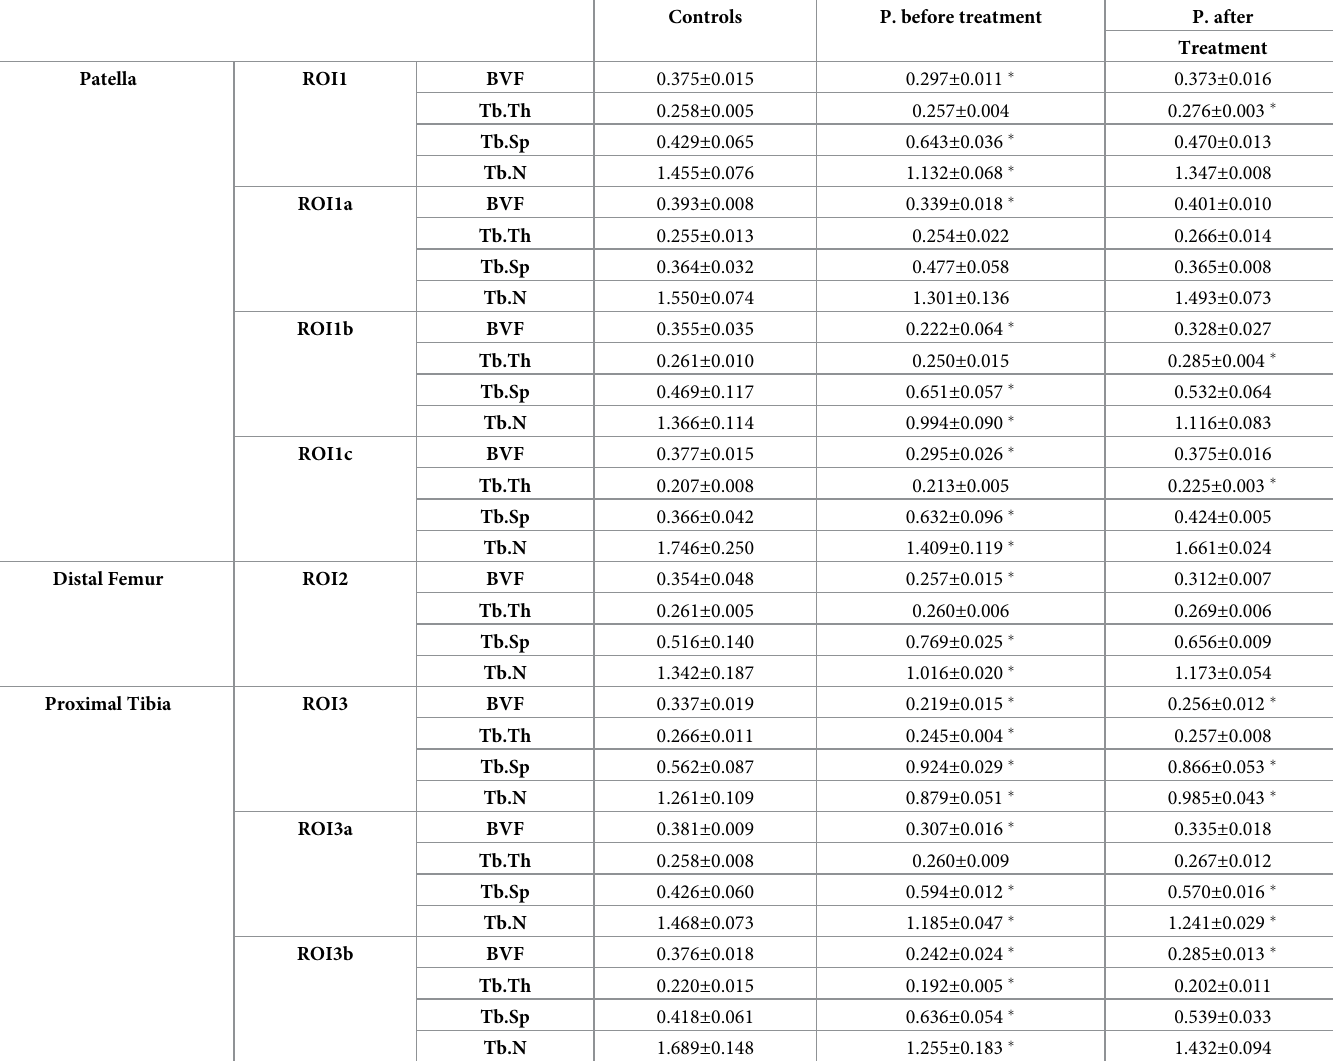
Table 2. Microarchitecture characteristics per